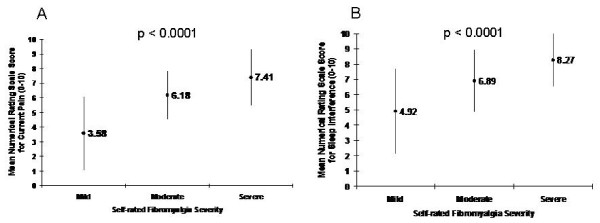
Relationship between self-reported fibromyalgia severity and current pain (A) and pain-related sleep interference (B). Values represent mean scores (± standard deviation as shown by the vertical bars) from the short form of the modified Brief Pain Inventory. P values are for the overall association between fibromyalgia severity and levels of current pain and pain-related sleep interference using ANOVA.